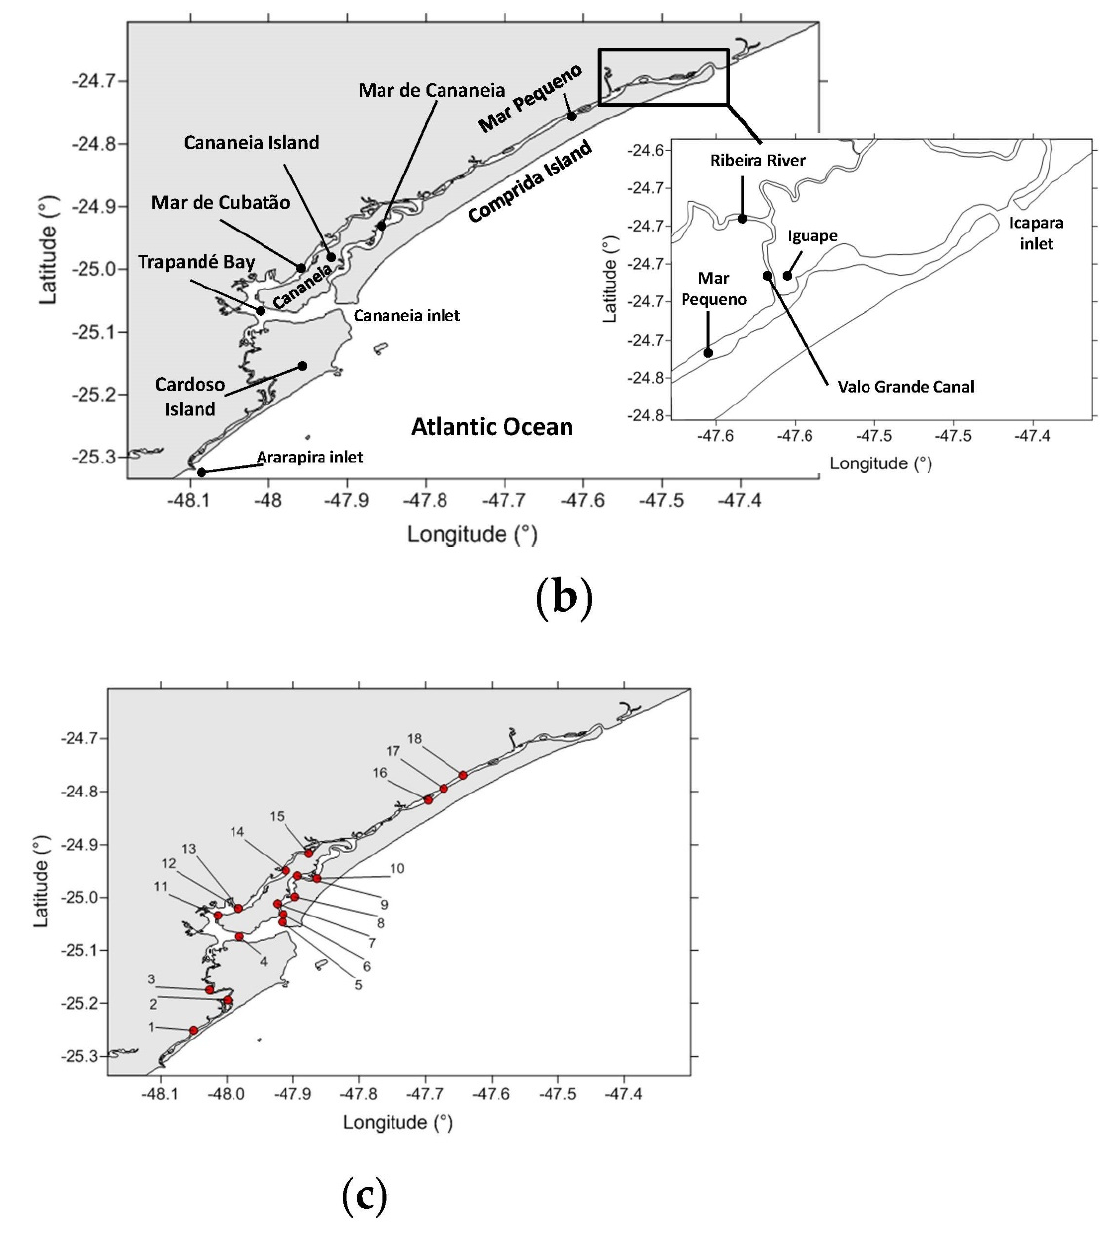
Figure 1. ( a ) Location of the city of Cananéia in south-western Brazil (National Geographic Map Maker). ( b ) Map of the Cananéia-Iguape estuarine–lagoon complex. Black rectangle corresponds to the inset map showing the city of Iguape, the Valo Grande Canal, and the Ribeira River. ( c ) Location of sampling stations.